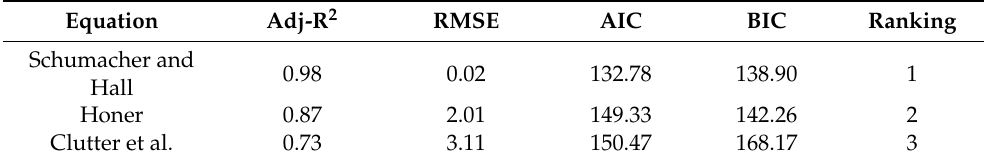
Table 2. Statistical values for selecting generalized volume equations for Eucalyptus. Equation BIC Ranking Schumacher